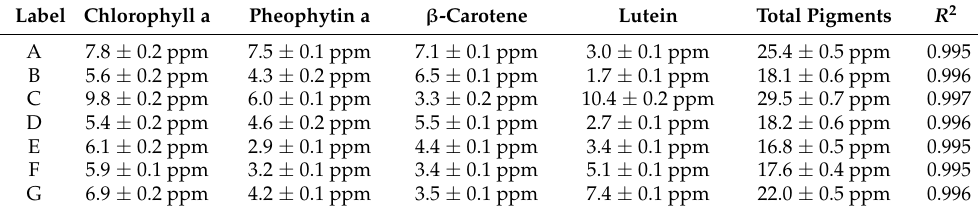
Table 3. Values of concentration (expressed in ppm) of four main pigments in fresh EVOOs (i.e., chlorophyll a, pheophytin a, β -carotene and lutein) as obtained from the deconvolution analysis of UV-vis absorption spectra the EVOO samples after about 1 month from their production. Other pigments, if present, are in smaller amount to produce significant improvement of the spectral analysis as reported in the text. Total amount of pigments is also reported. For each EVOO sample the concentration values obtained from the best fitting analysis are shown with the respective value of R 2